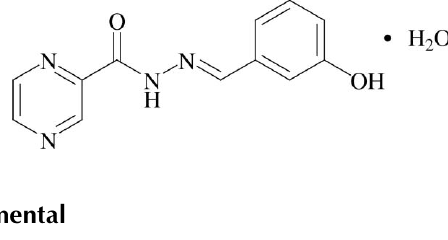
hydrazonecarbonyl compounds, see: Parashar et al. (1988); Hadjoudis et al. (1987). For related pyrazinecarboxylic acid hydrazones, see: Gardner et al. (1956);